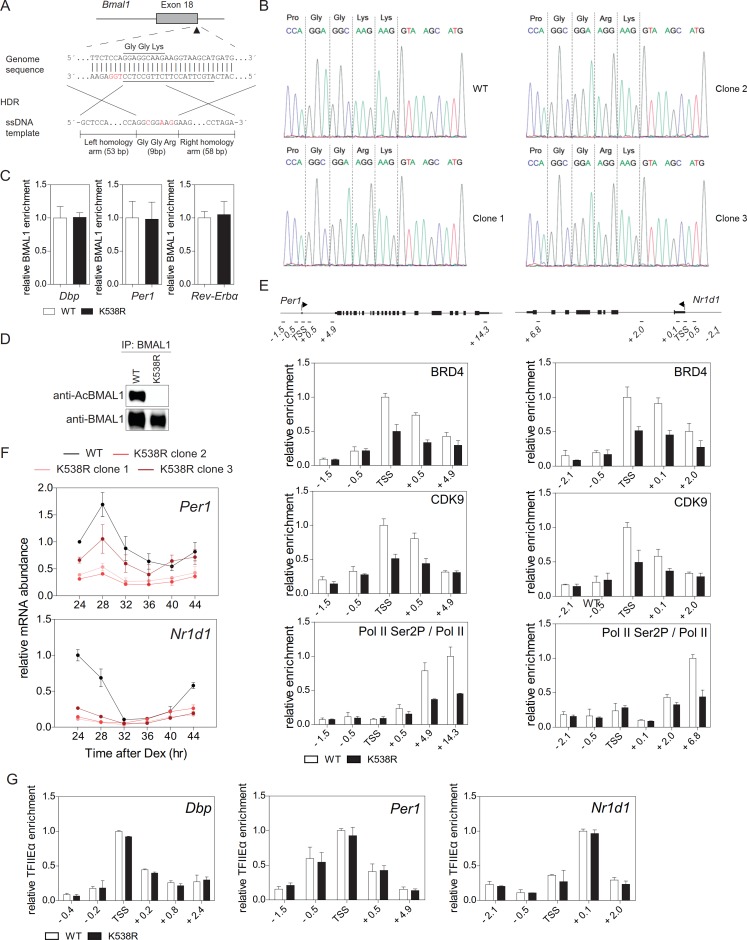
CRISPR/Cas9-mediated generation and characterization of BMAL1K538Rmutant cells.(A) Schematic representation of the gene targeting strategy for generating BMAL1K538R mutant cells using the CRISPR/Cas9 system. The gRNA-targeting sequence is underlined and the PAM sequence is indicated in red. The oligonucleotide donor (120 bp) is shown below the targeted site, with the Lys-to-Arg substitution indicated in red. Silent point mutations were introduced for the two adjacent Gly to prevent cutting of the donor DNA or re-cutting of the genome after homology-directed recombination (shown in red). (B) Representative sequencing results from PCR amplicons of the Lys538 region from three individual clones that were subsequently used for experimental work. Primer sequences are specified in Supplementary file 2. (C) ChIP analysis of BMAL1 binding to Dbp, Per1, and Nr1d1 genes in wildtype and BMAL1K538R synchronized fibroblasts 24 hr after Dex synchronization (n = 3). (D) BMAL1 IPs from wildtype or BMAL1K538R fibroblast nuclear extracts carried out 24 hr after Dex synchronization of fibroblasts were immunoblotted with anti-AcBMAL1 and anti-BMAL1 antibodies. (E) BRD4, CDK9, and Ser2P-Pol II (normalized to total Pol II) ChIP analysis of Dex synchronized wildtype or BMAL1K538R fibroblasts (n = 3). (F) Per1 and Nr1d1 mRNA expression analysis of wildtype or BMAL1K538R fibroblasts (n = 3, two-way ANOVA, see Supplementary file 1). (G) ChIP analysis of TFIIEα binding to Dbp, Per1, and Nr1d1 genes in wildtype and BMAL1K538R synchronized fibroblasts (n = 3). All data are shown as mean ± SD.